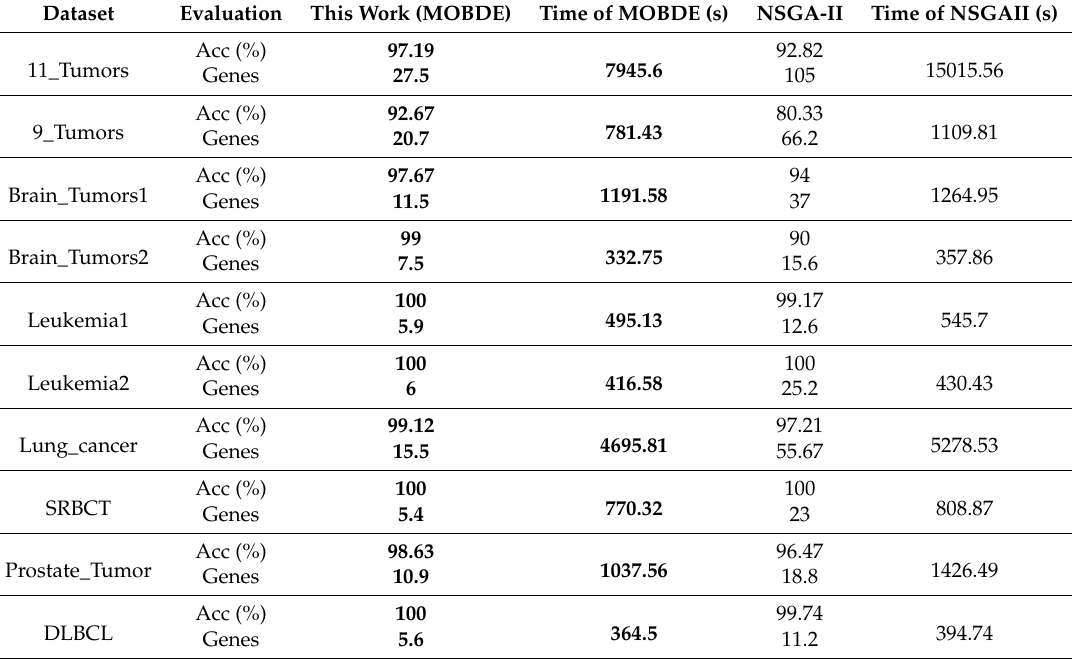
Table 13. Comparative experimental results of the binary differential evolution algorithm with a different multiobjective optimization